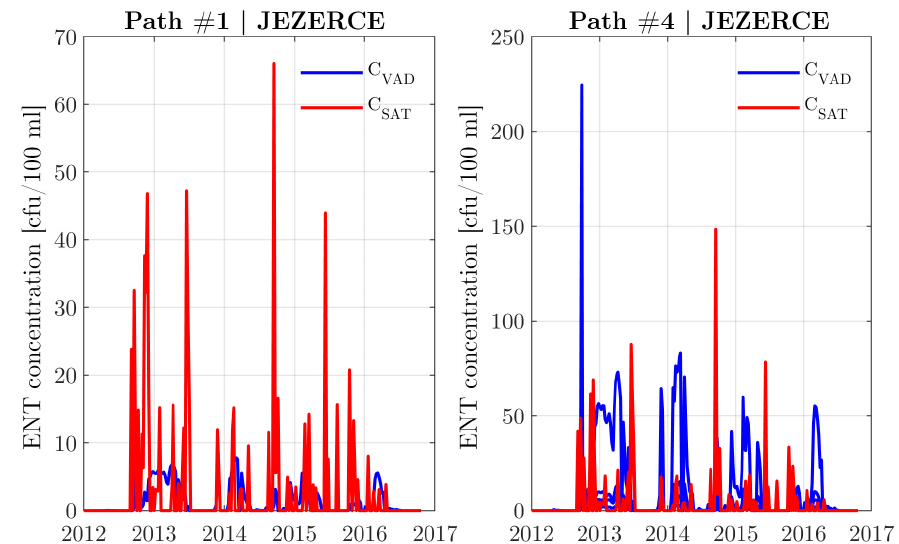
Figure 13. Diagrams of C VAD and C SAT concentrations for flow paths 1 and 4 towards Jezerce well obtained with optimal combinations of the variation parameters values (Table